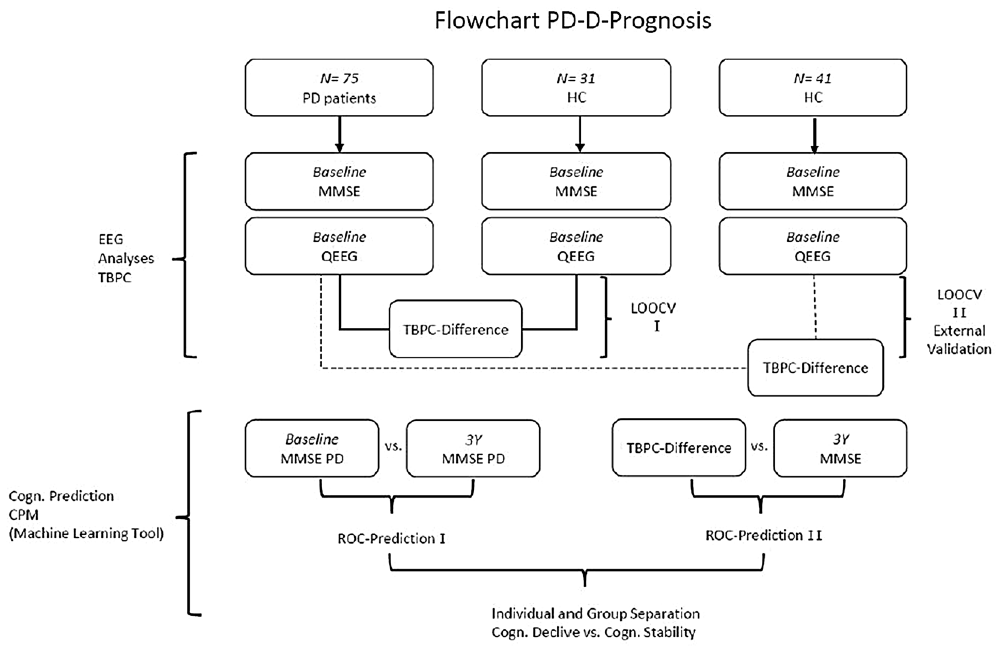
Figure 1. TBPC (time-between-phase-crossing) CPM (connectome-based modeling) MMSE (Mini Mental State Examination) QEEG (quantitative electroencephalography) LOOCV (leave-one-subject-out cross validation).